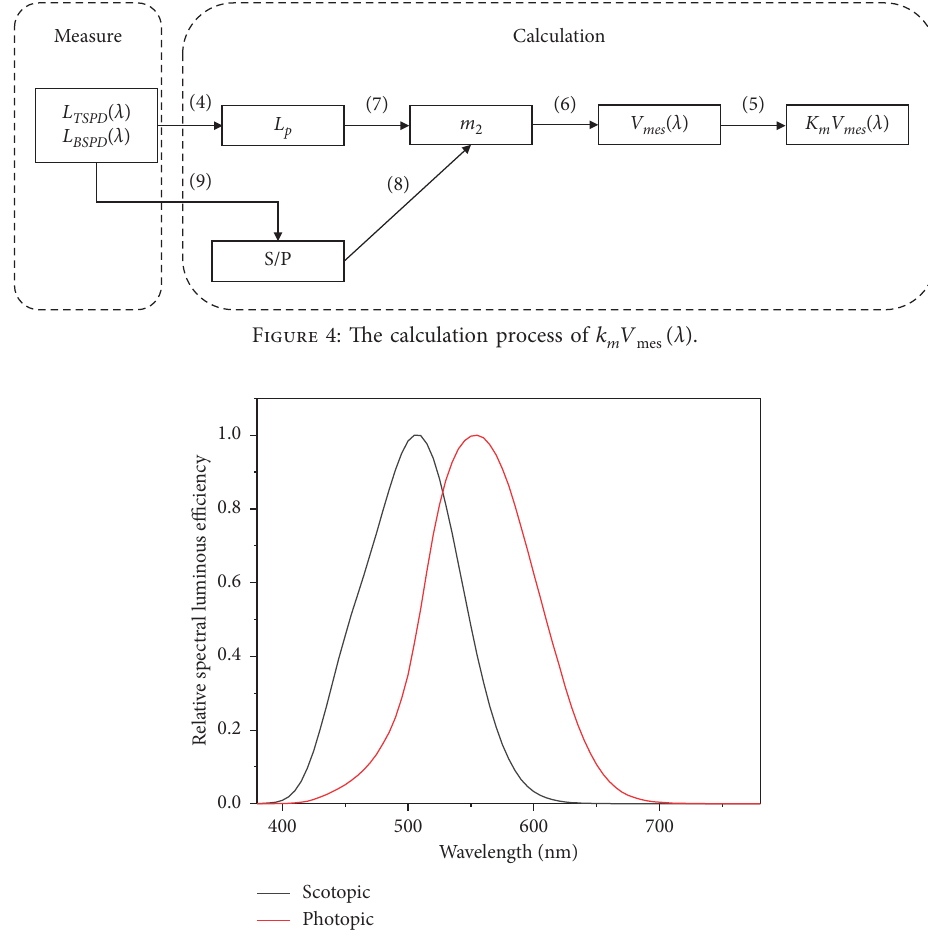
Figure 5: Relative spectral luminous efficiency curves of photopic and scotopic.